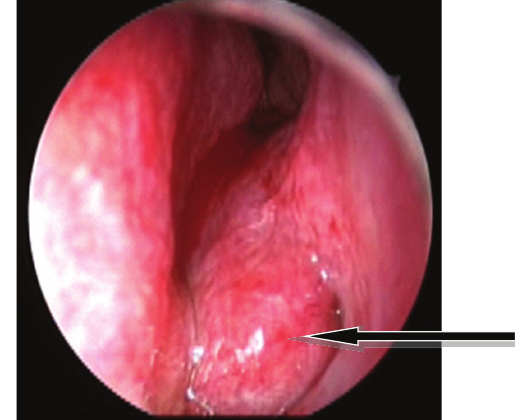
Figure 1: Anterior rhinoscopic view showing the mass arising from the left inferior turbinate.